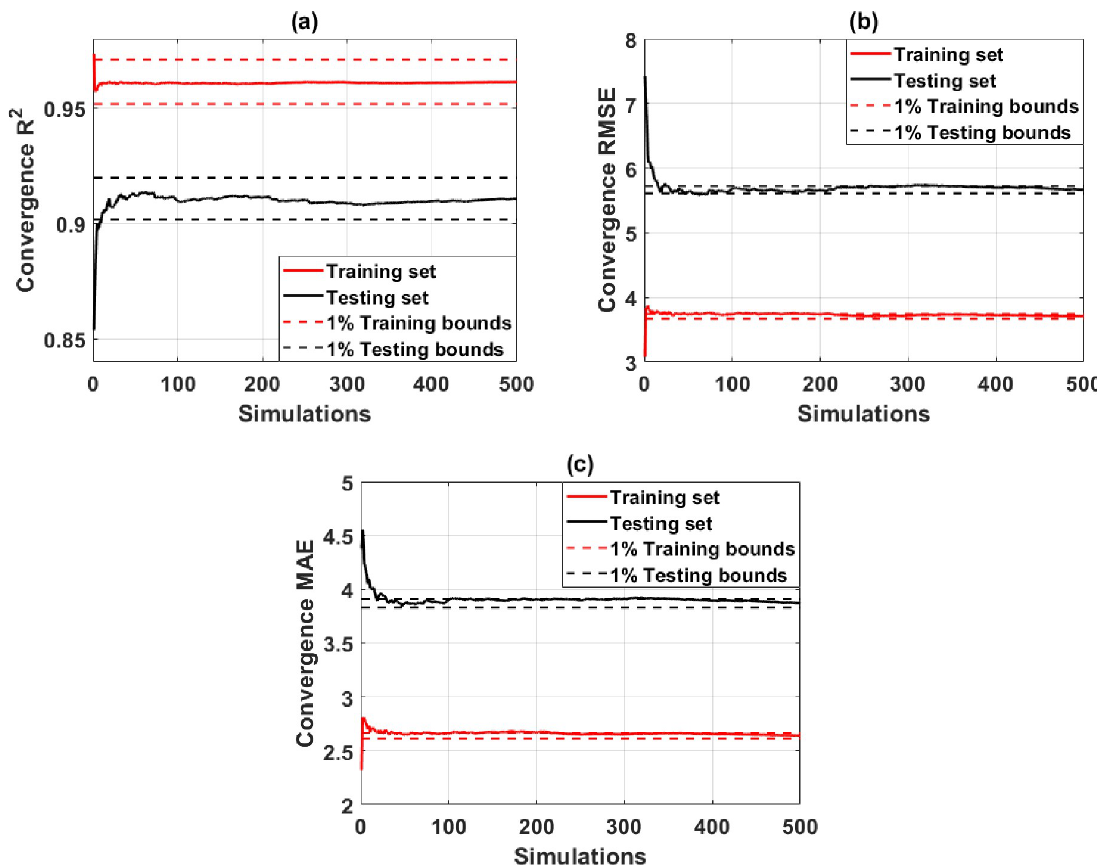
Fig 7. Convergence study of ANN [8–14–4–1] architecture in terms of (a) the R 2 of the training and testing parts; (b) RMSE of the training and testing parts; (c) MAE of the training and testing parts. https://doi.org/10.1371/journal.pone.0260847.g007 the samples’ percentage error within a range. For example, with the training dataset, the per- centage of sample with the error between the experimental values and simulated ANN is in the range [-10; 10] MPa is 97%. This is similar to the testing dataset.